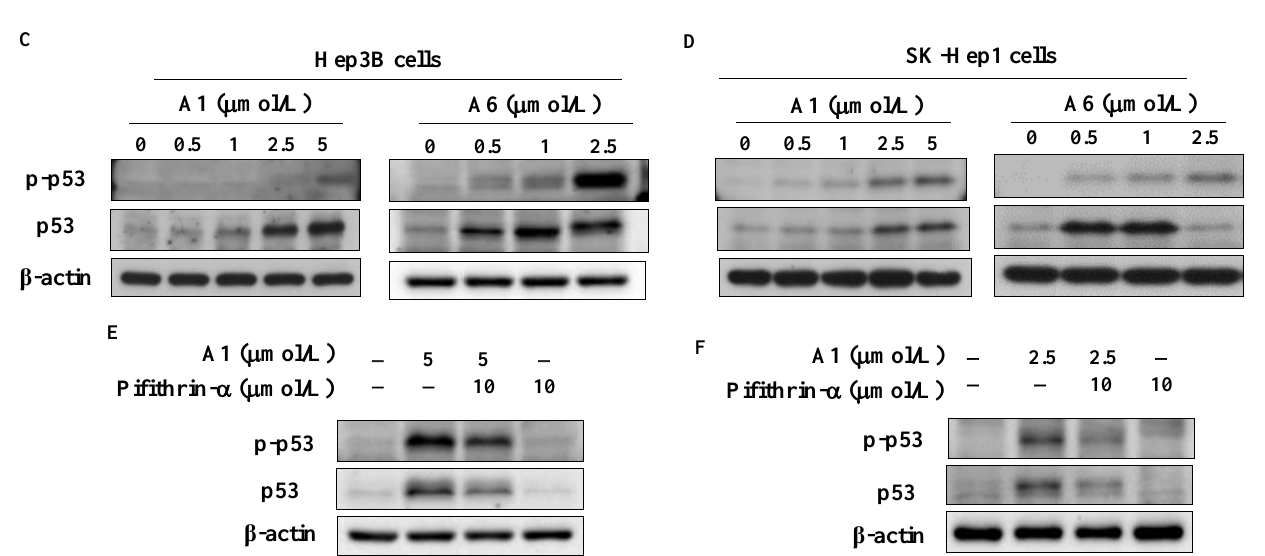
Figure 6. Analysis of reactive oxygen species (ROS) in A1- and A6-treated HCC cells. ( A ) Cells were treated with A1, A6, or DMSO for 3 h and stained with carboxy-DCFDA. H 2 O 2 (300 µ mol/L) was used as a positive control. ( B ) Left, cells were treated with A1 or in combination with N -acetylcysteine (NAC) or glutathione (GSH) for 3 h. Right, cells were treated with A6 or in combination with NAC or GSH for 3 h. Data are presented as the mean ± S.D. ( n = 3). ** p < 0.01. ( C ) Expression of p-p53 and p53 after treatment with A1 and A6 in Hep3B cells and ( D ) SK-Hep1 cells. Phosphorylation and expression of p53 in Hep3B cells treated with ( E ) A1 (5 µ mol/L) and ( F ) A6 (2.5 µ mol/L) alone or co-treated with pifithrin- α (10 µ mol/L) for 48